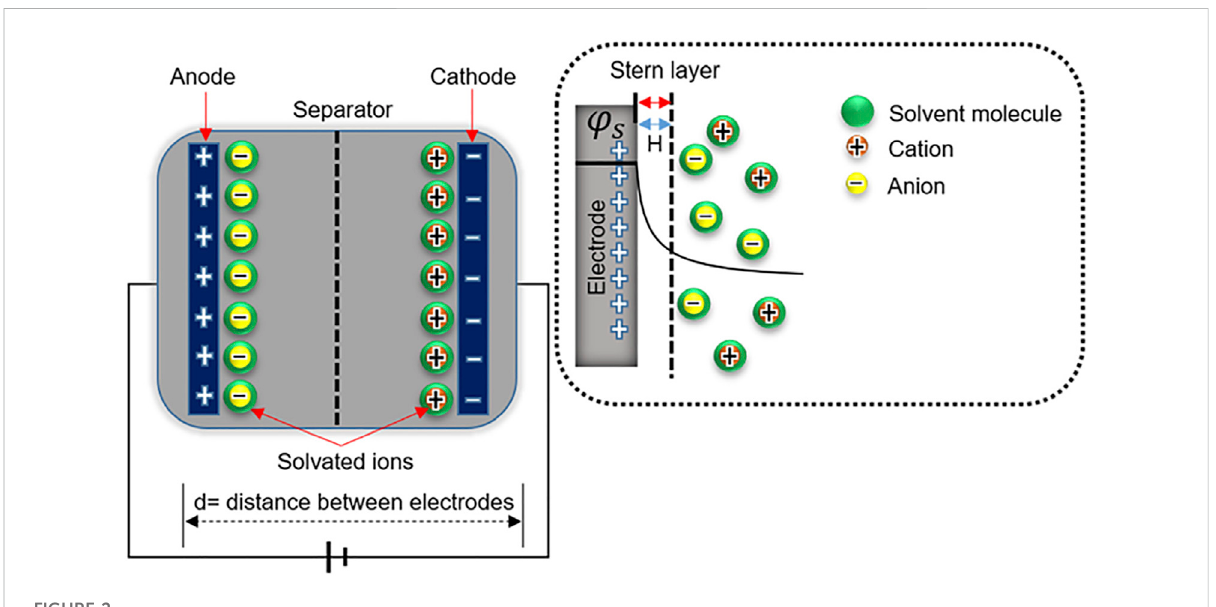
FIGURE 2 Working mechanism of EDLCs (Bokhari et al.,